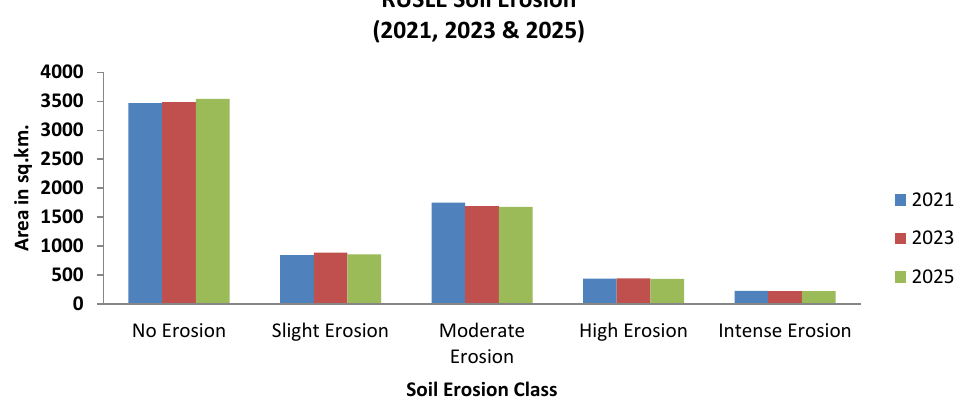
Fig. 8: Area under different soil erosion classes for the year 2021, 2023 and 2025 (Areas in km 2 )